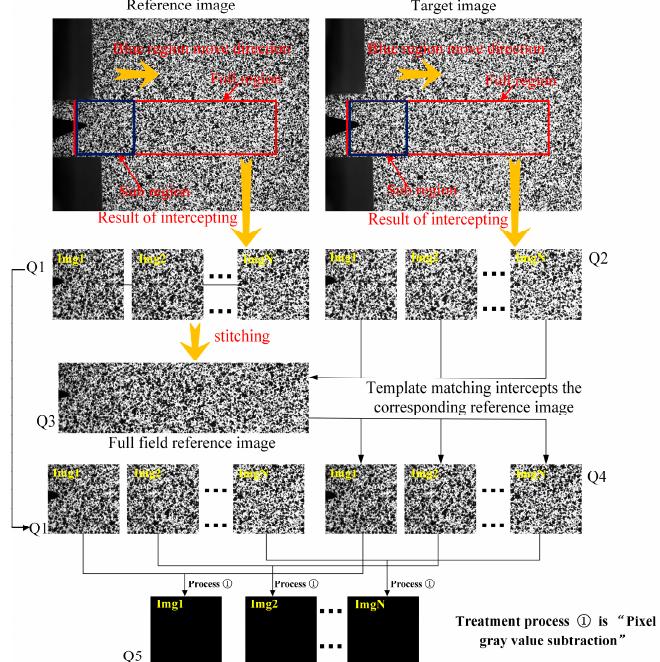
Figure 15. Template matching verification process.